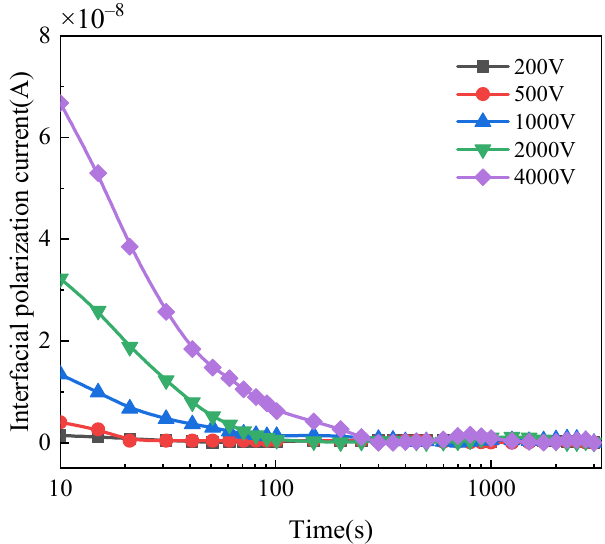
Figure 10. Interface polarization current of bushings with different moisture conditions.